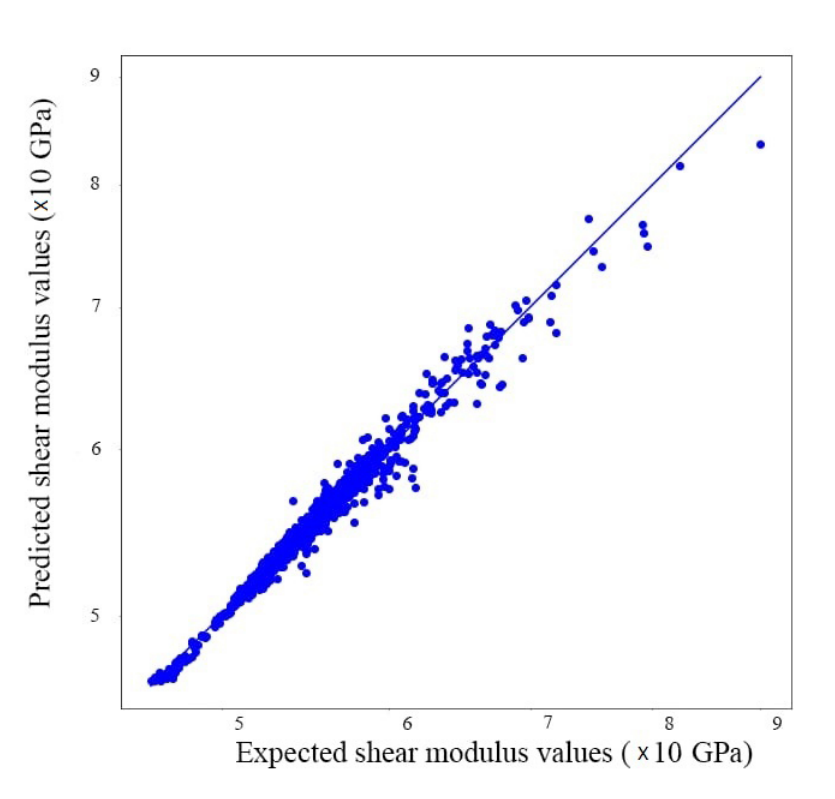
Figure 12. Convolutional predictions for the shear modulus.